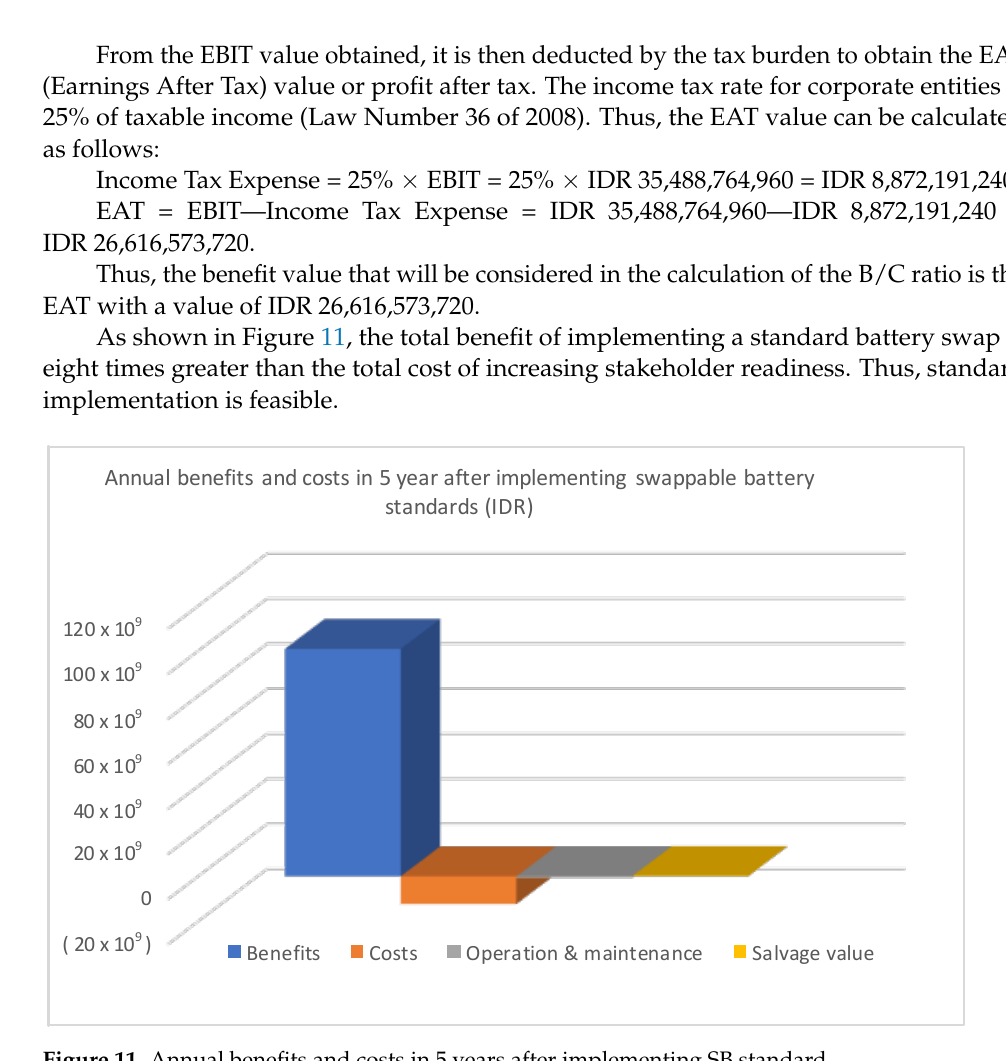
Figure 11. Annual benefits and costs in 5 years after implementing SB standard.